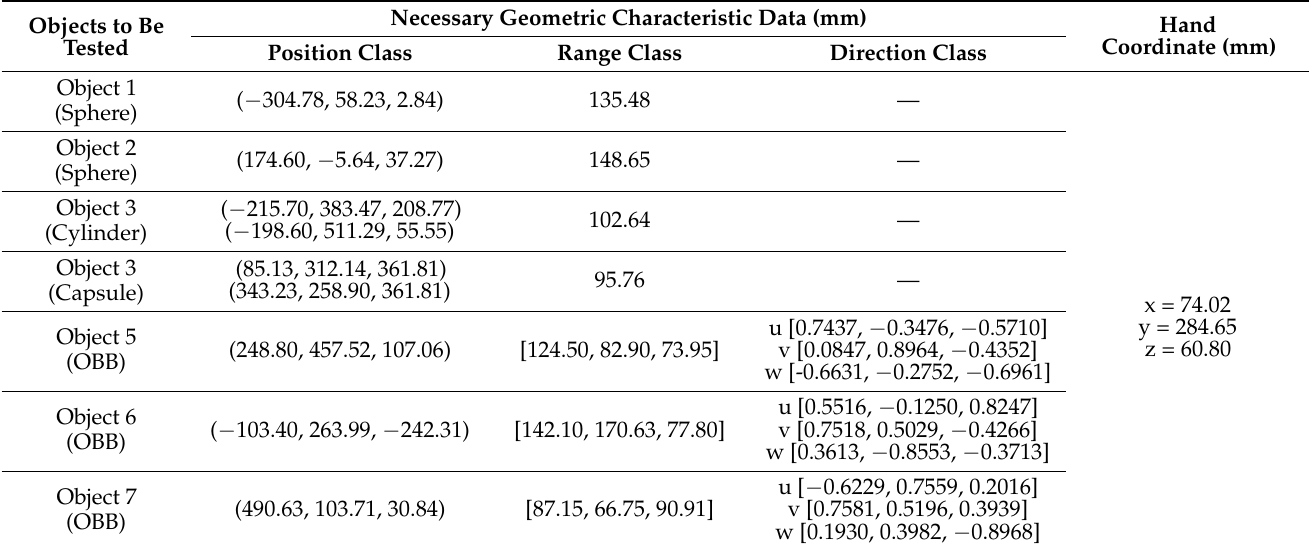
Table 5. Necessary Geometric Characteristic Data of the Object in Scene